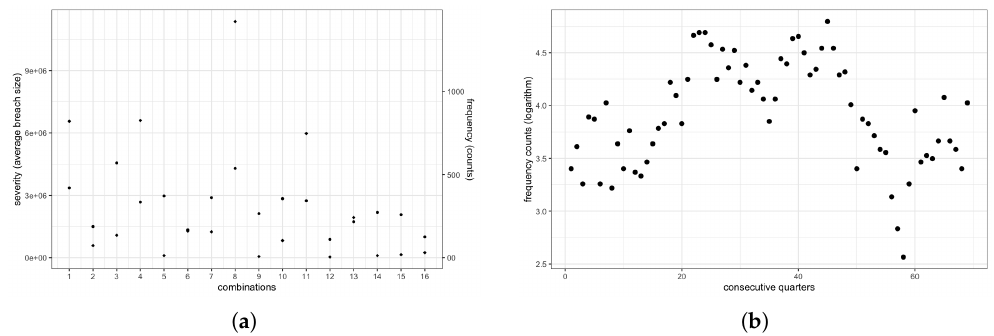
Figure 3. Effects decomposition, ( a ) Scaled frequency and severity, ( b ) Polynomial time trend